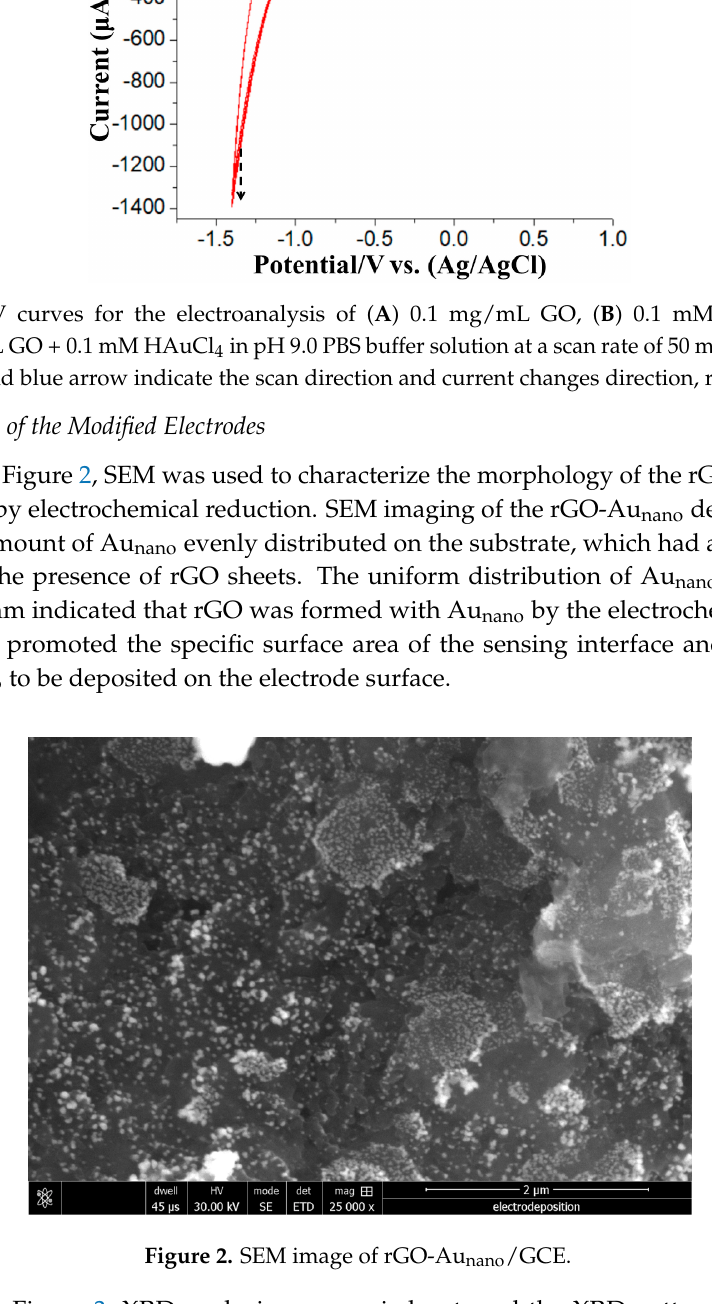
Figure 2. SEM image of rGO-Au nano /GCE.